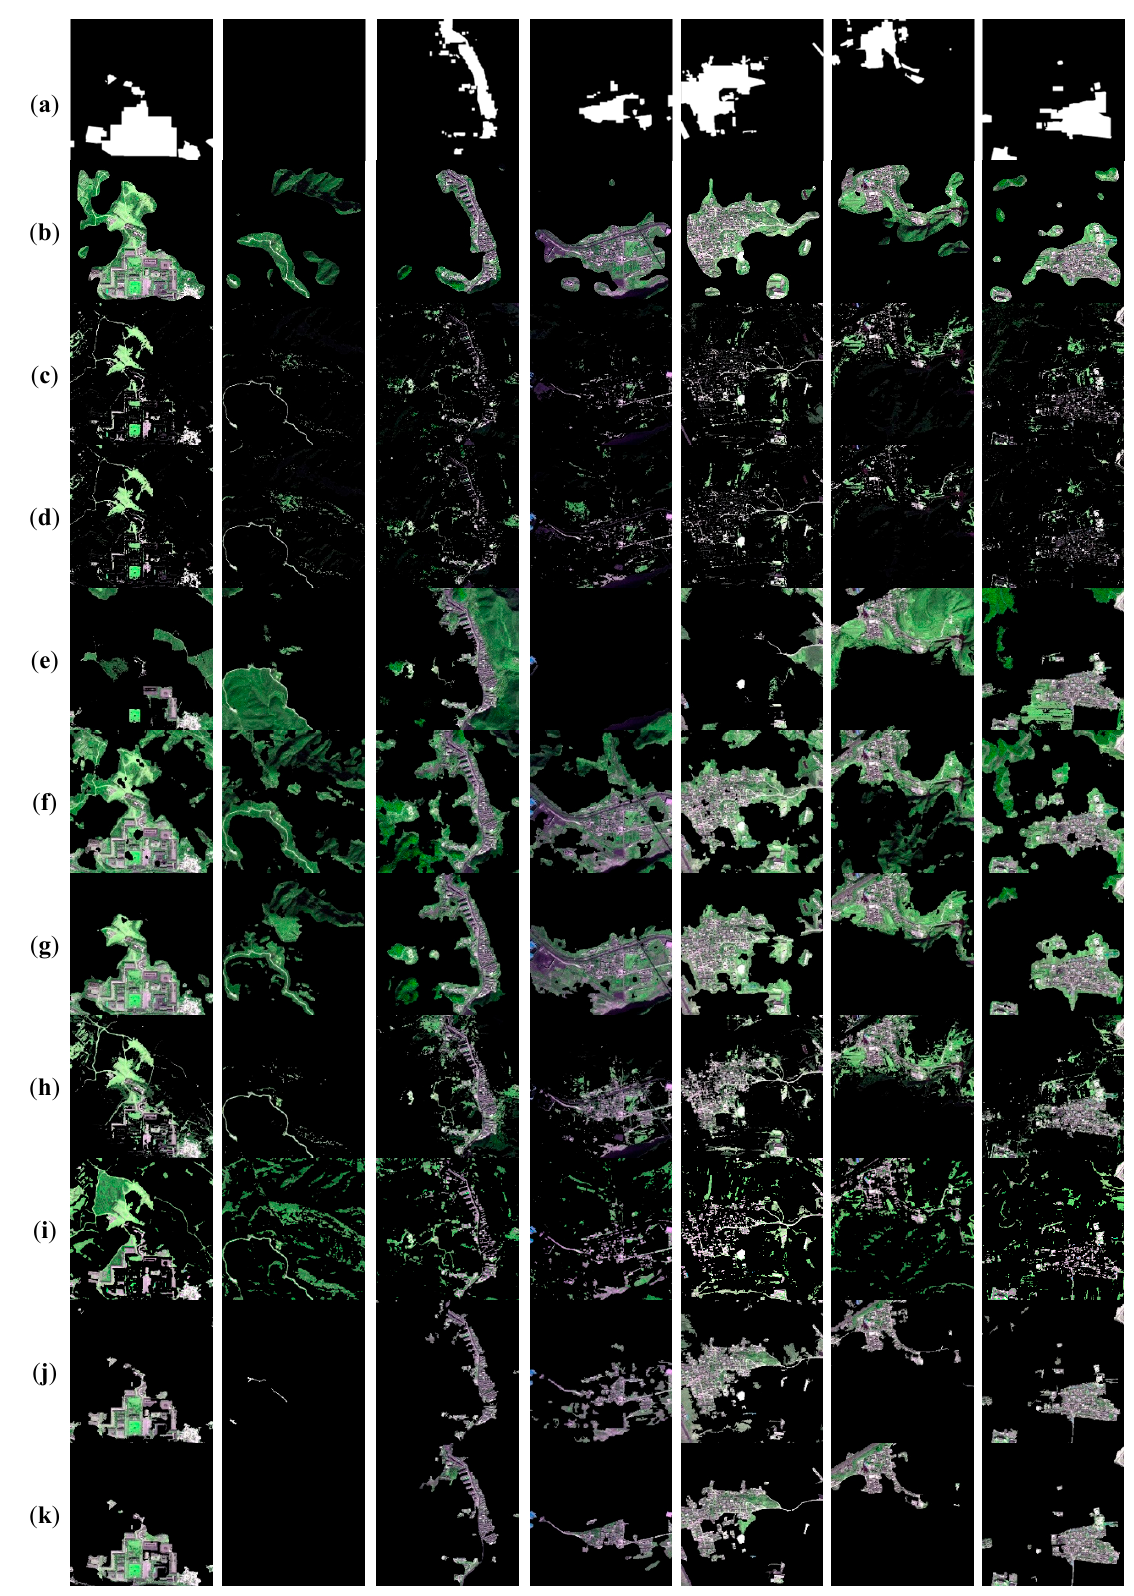
Figure 13. Visual comparison of ROIs from Group GeoEye - Residential area . From top to bottom are ( a ) manual ground truth masks; ( b ) ITTI; ( c ) FT; ( d ) MSSS; ( e ) CB; ( f ) SIM; ( g ) CA; ( h ) TMM; ( i ) FDA-SRD; ( j ) JMS; and ( k ) EP-JMS.